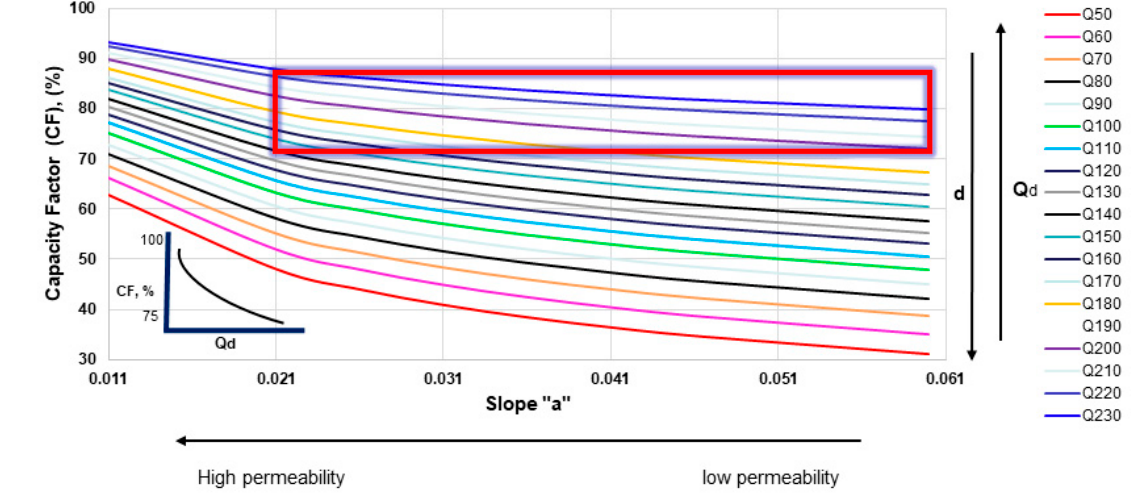
Figure 8. Slope in relation to the capacity factor (CF).